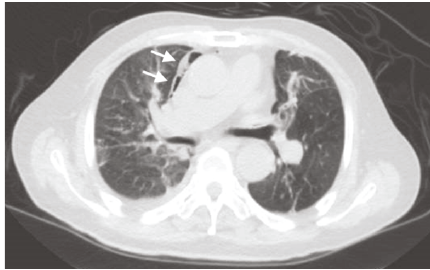
Figure 4: CT scan of thorax illustrating presence of pneumomedi- astinum at the level of the aortic arch.